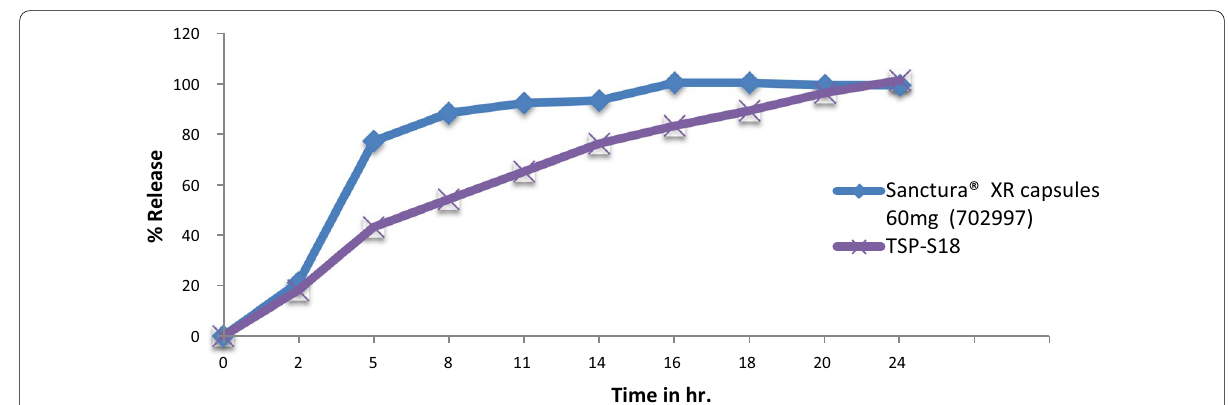
Fig. 4 Comparative dissolution results of marketed and optimized osmotic tablet formulation